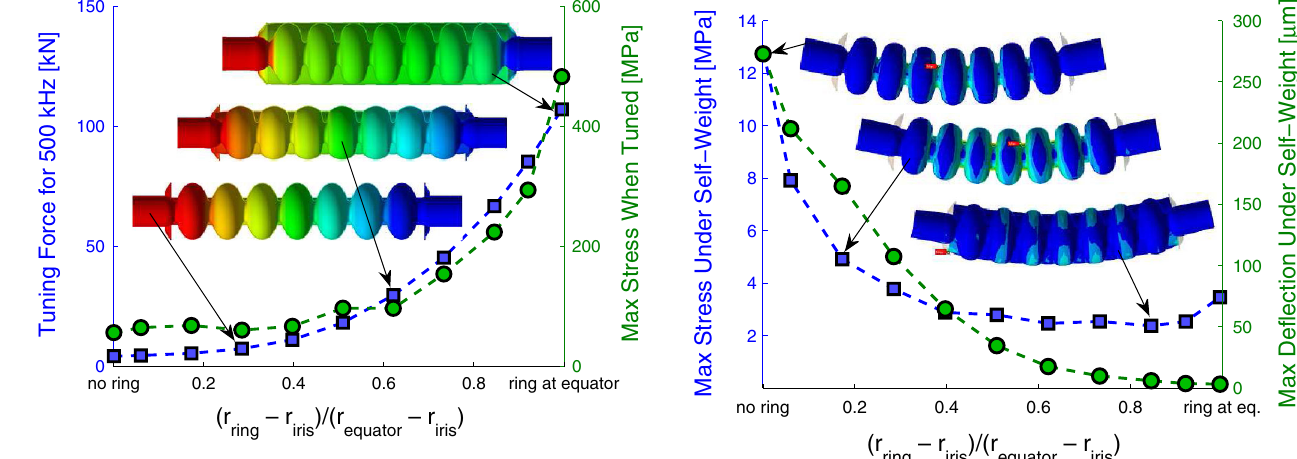
FIG. 14. Required force for frequency tuner and maximum stress in the cavity at maximum tuning. Inset are images showing deflection in the cavity for selected stiffening ring radii. Blue locations are least deflected, and red locations are most deflected.